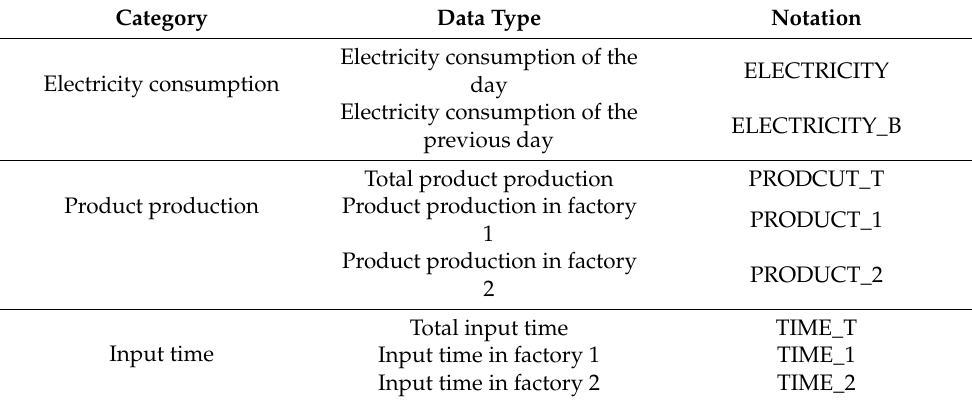
Table 4. Data for electricity consumption